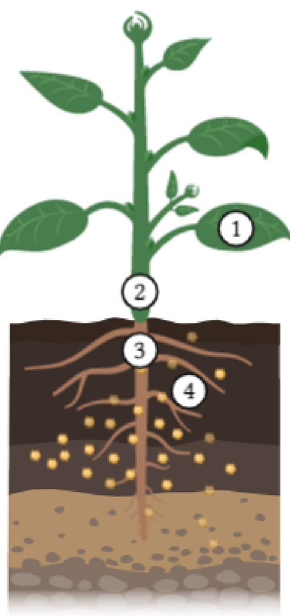
Fig. 1 PGPMs enhance phytoremediation processes in plants by plant biomass expedition (1), bioaccumulation or metal transloca- tion facilitation from soil to root (2), translocation or transport from root to shoot tissues (3), increase in heavy metal availability in soil by phytoextraction or decrease in metal availability in soil in phyto- stabilization